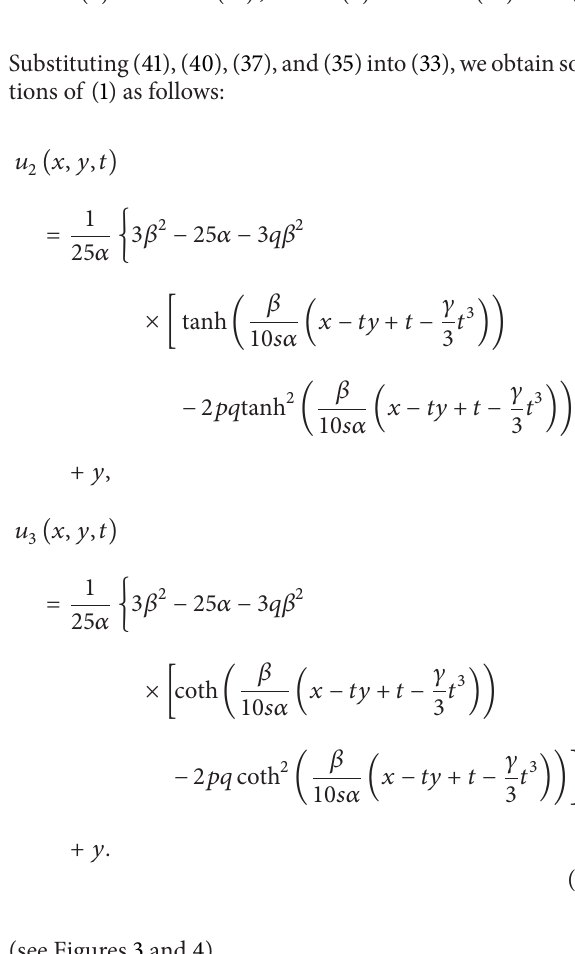
Figure 2: The periodic solution which is a periodic nontraveling wave traveling on the 𝑡 -axis for 𝑢 1 (𝑥,𝑦,𝑡) as 𝑦 = 1